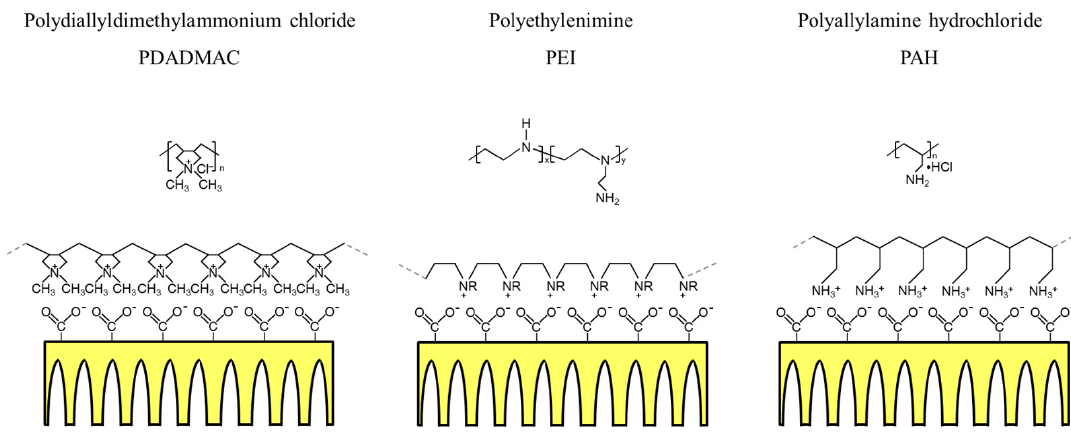
Figure 6. Schematics demonstrating the deposition of various polycations (including PDADMAC, PEI, and PAH) onto the PAN substrate with the alkaline treatment.